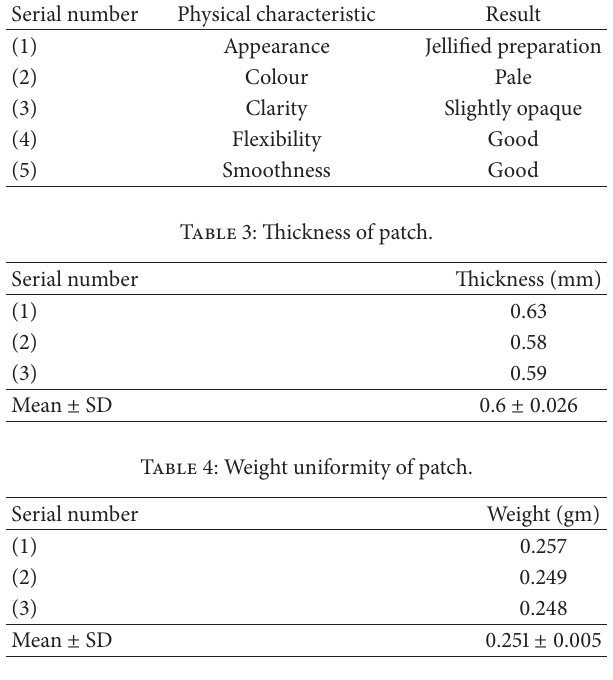
Table 8: In vitro permeation study of